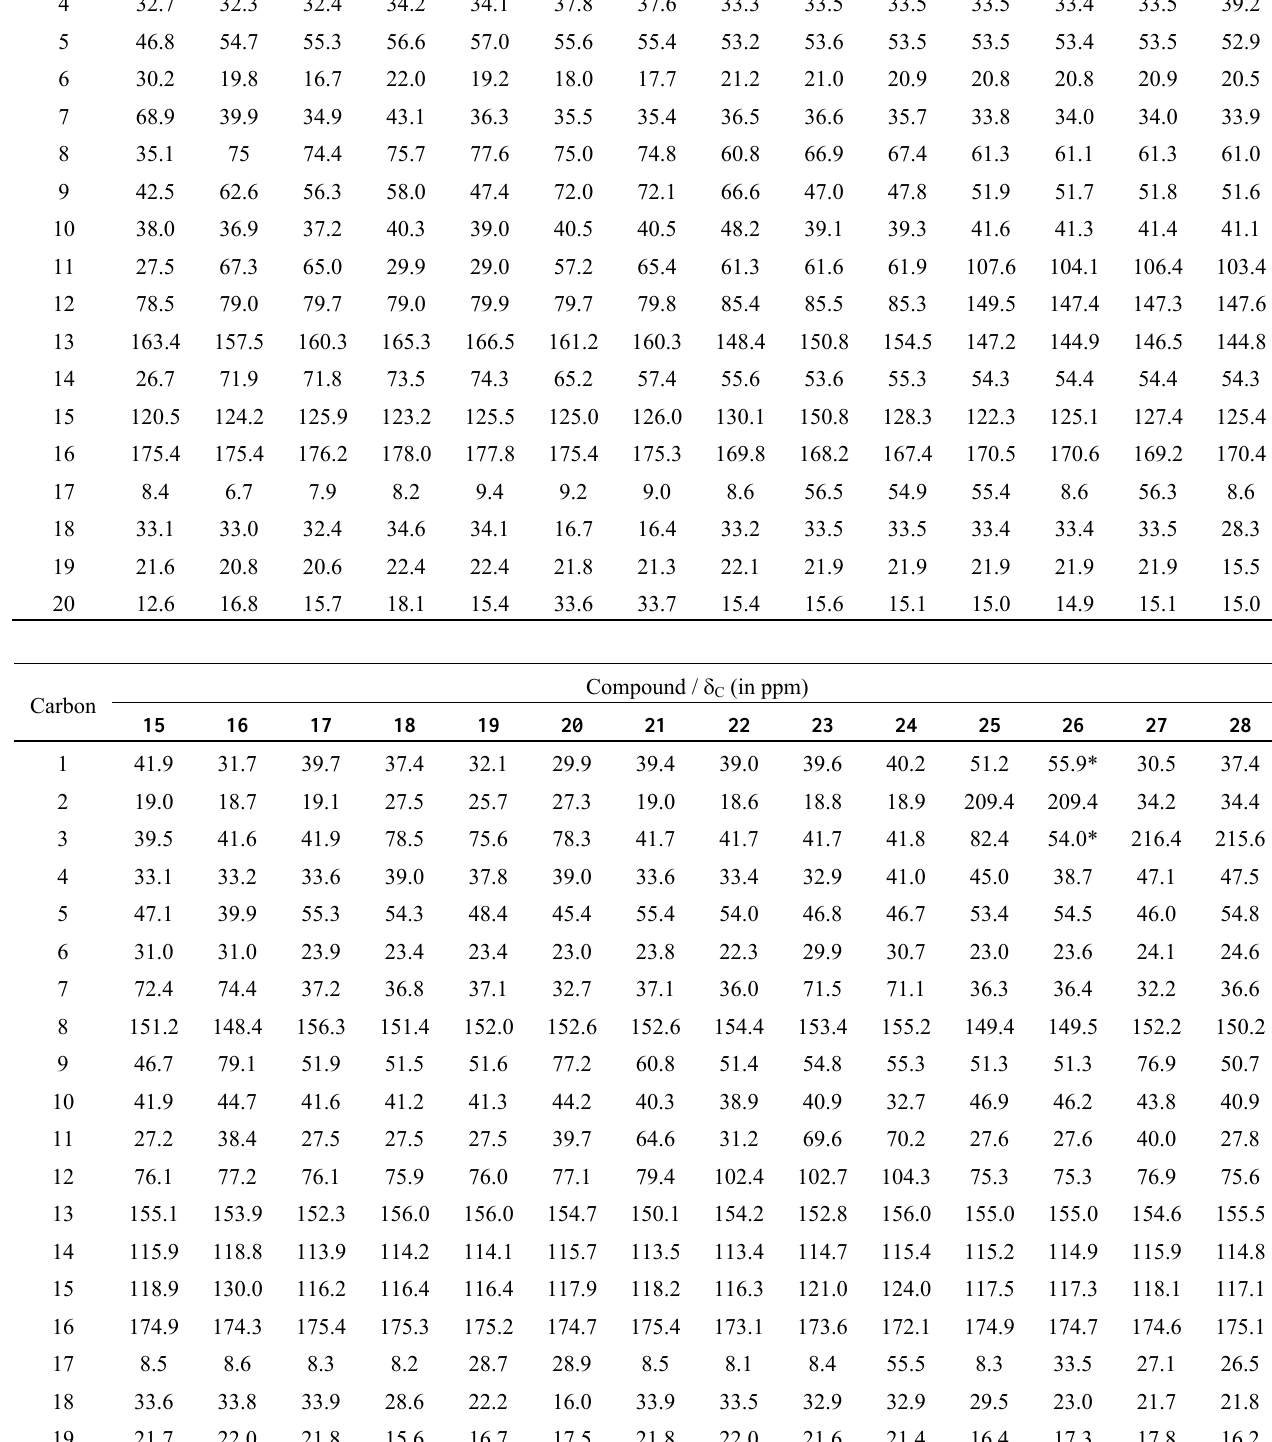
Table 4. 13 C-NMR data (in CDCl